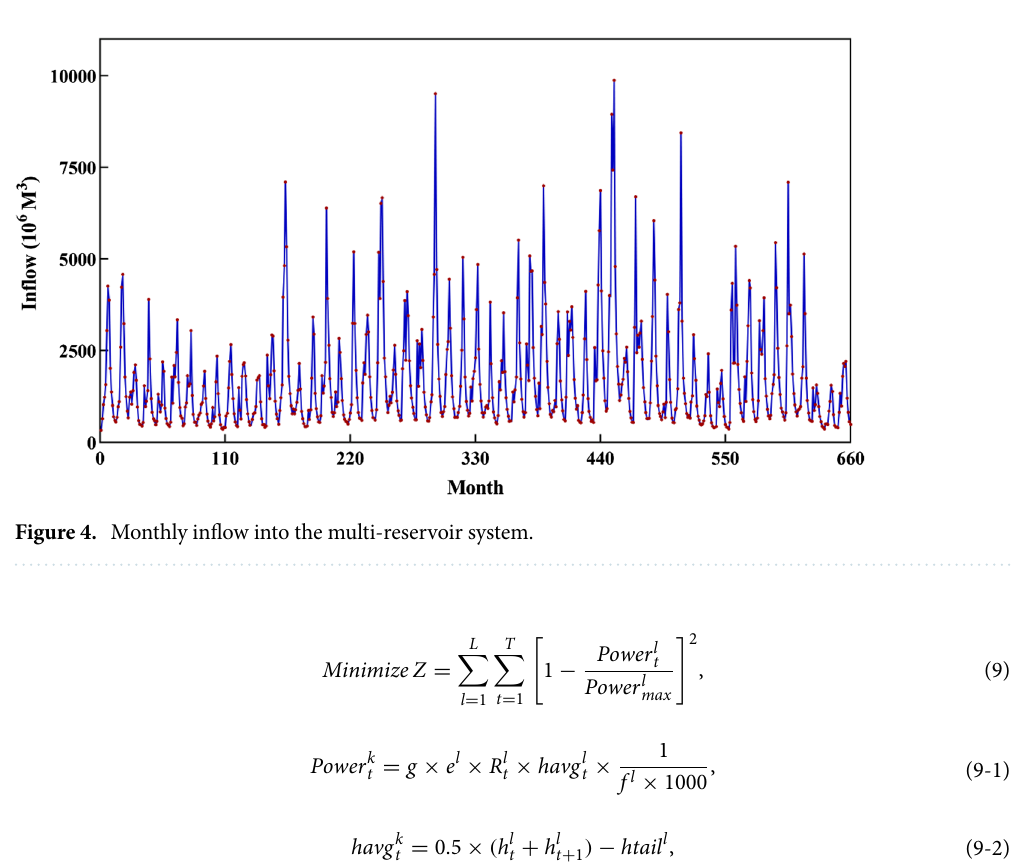
Figure 3. Diagram of the real-world multi-reservoir system.